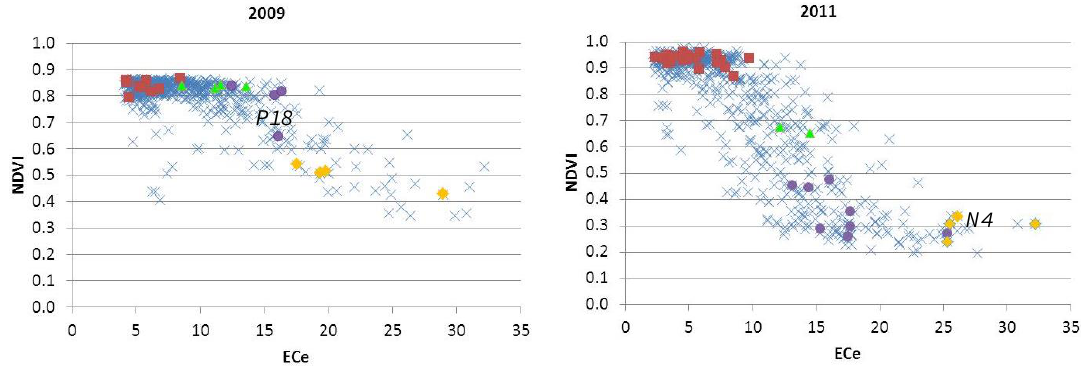
Figure 7. Scatter diagram of NDVI in April versus ECe (dS m − 1 ) for the years 2009 and 2011. Each cross represents a pixel, with the sampling sites highlighted in colors according to their vegetative activity.